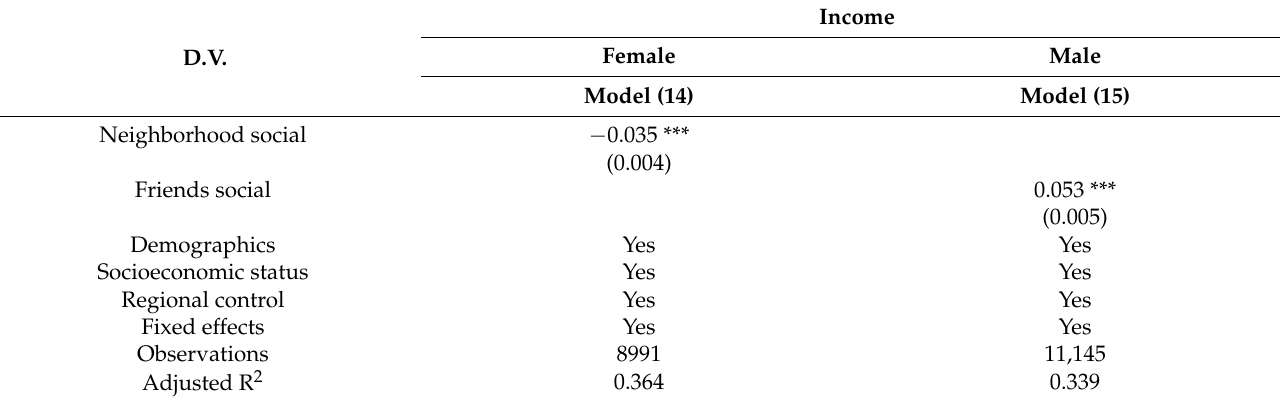
Table 9. Regression results of socialization impact on